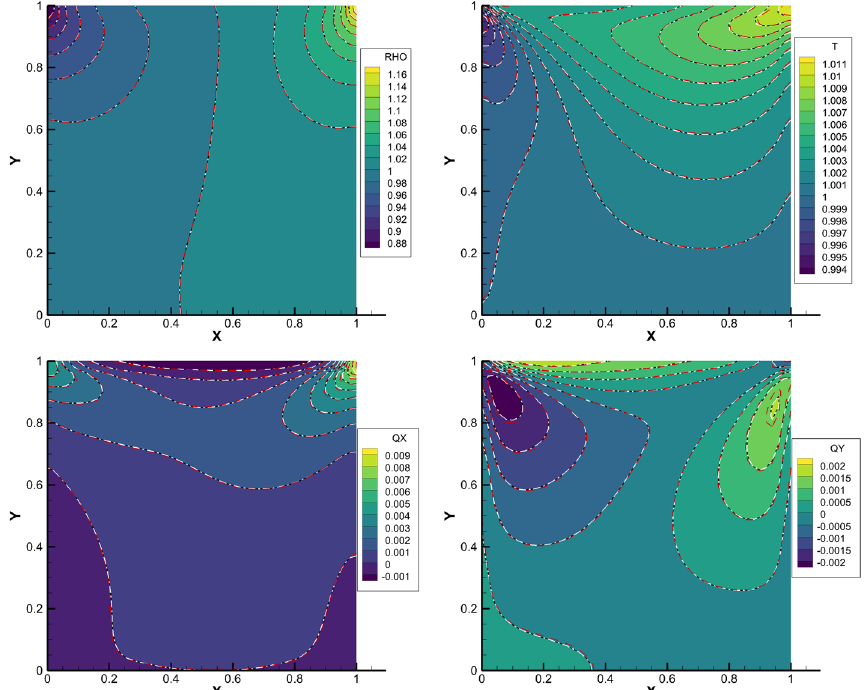
Fig. 3 Comparison of density, temperature, x -component of heat flux and y -component of heat flux contours for lid-driven cavity flow at Kn 0.075 (ADUGKS: colored background; DUGKS: white dash-dot line; = UGKS: red dash